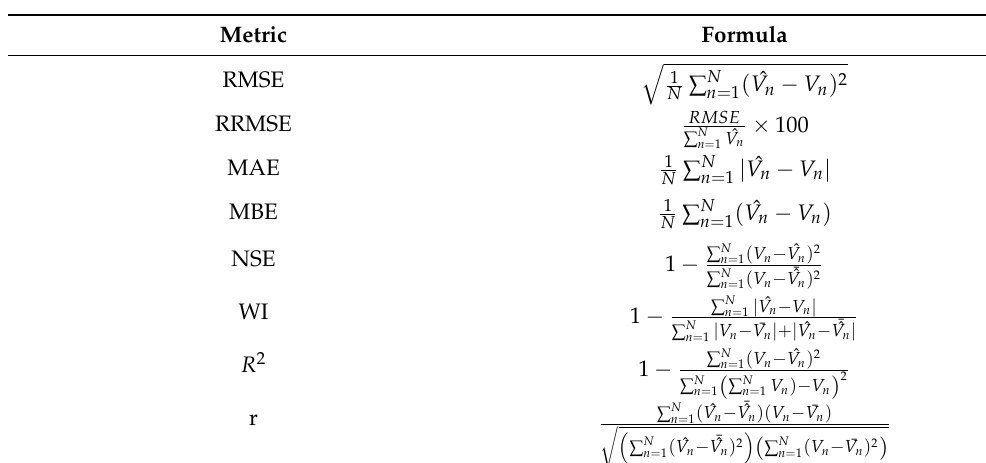
Table 4. Prediction results evaluation